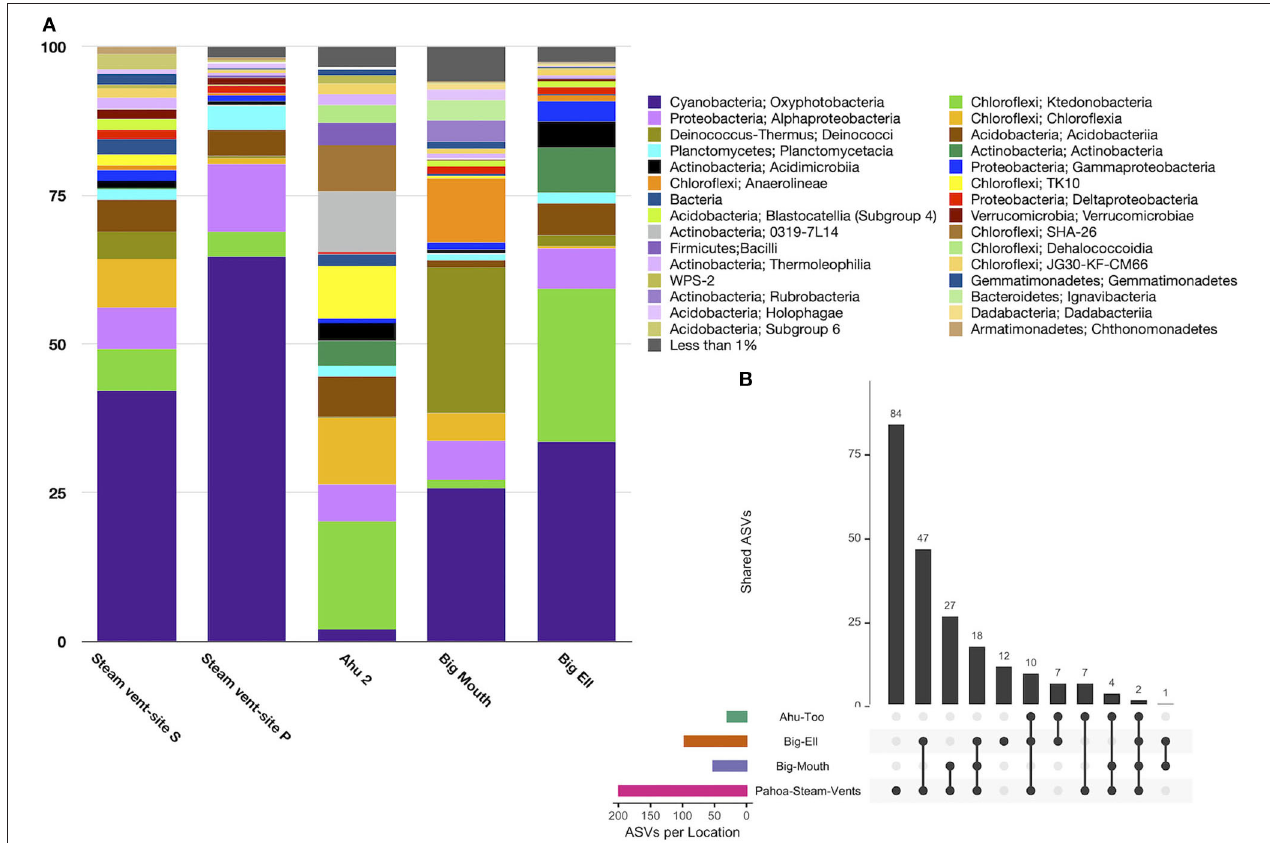
FIGURE 3 | (A) Relative abundance by the site of class-level taxa with > 1% abundance in geothermally active sites. Geothermal caves are dominated by Cyanobacteria (Oxyphotobacteria; 40.2% ± 25.3) and Chloroflexi including classes Ktedonobacteria (10.6% ± 15.9) and Chloroflexia (5.8 ± 9.8). Steam vent sites hosted the highest abundance of Oxyphotobacteria. Ktedonobacteria was higher in geothermal caves. Deinococci were most abundant in K ¯ ılauea Caldera’s Big Mouth cave. (B) Upset plot illustrating overlapping ASVs among geothermal sites. Steam vents hosted many unique ASVs (2,518), followed by Big Ell cave. This shows that geothermal sites are largely unique environments, with few overlapping ASVs; the highest number of overlapping ASVs was in Big Ell and Pahoa Steam vents, which may in part be due to the larger number of samples from these locations. Only one ASV occurred in all sites (Class Oxyphotobacteria, Chlorogloeopsis